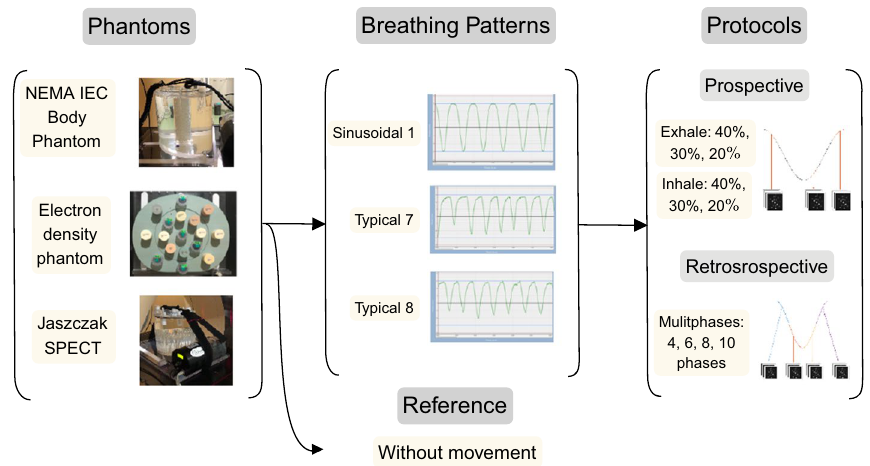
Fig. 1 Materials and methods used for the comparison of the different protocols for respiratory motion